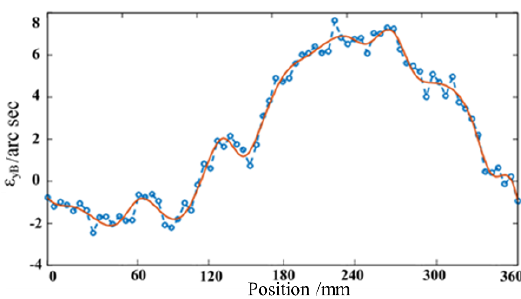
Figure 11. Rotation displacement error ε yB ( B ) for the B − axis. The fitted geometric error can be used in actual kinematic relation in Equation (15).